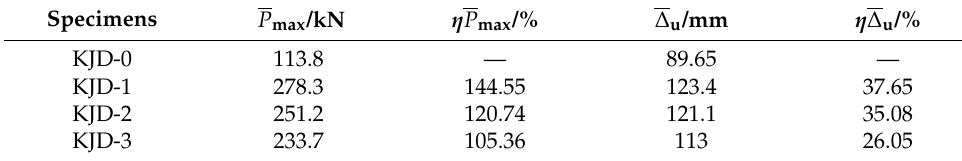
Table 5. Comparison between mean P max and ∆ u .